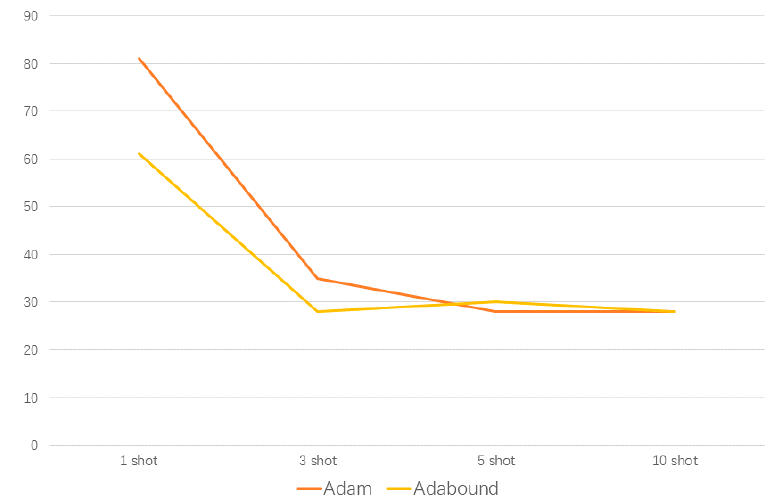
Figure 10. The episodes required to achieve 96% accuracy.